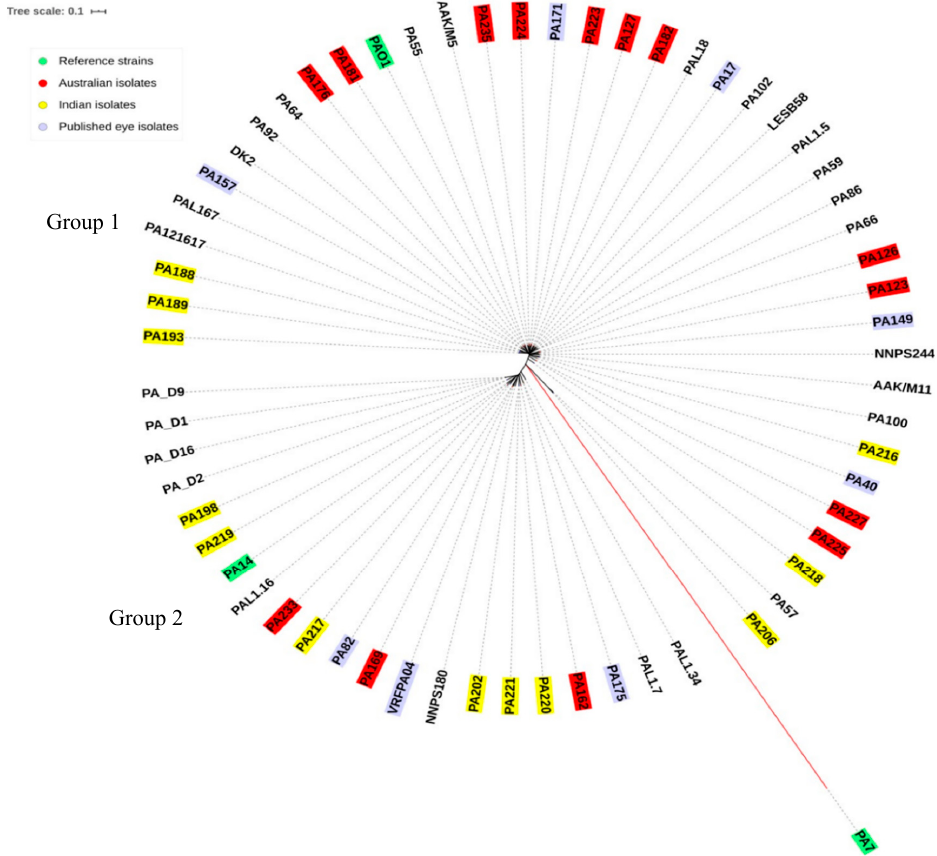
Figure 1. Core genome phylogeny of P. aeruginosa isolates using Parsnp. PAO1 was used as reference. PA7 and PA14 were also included.